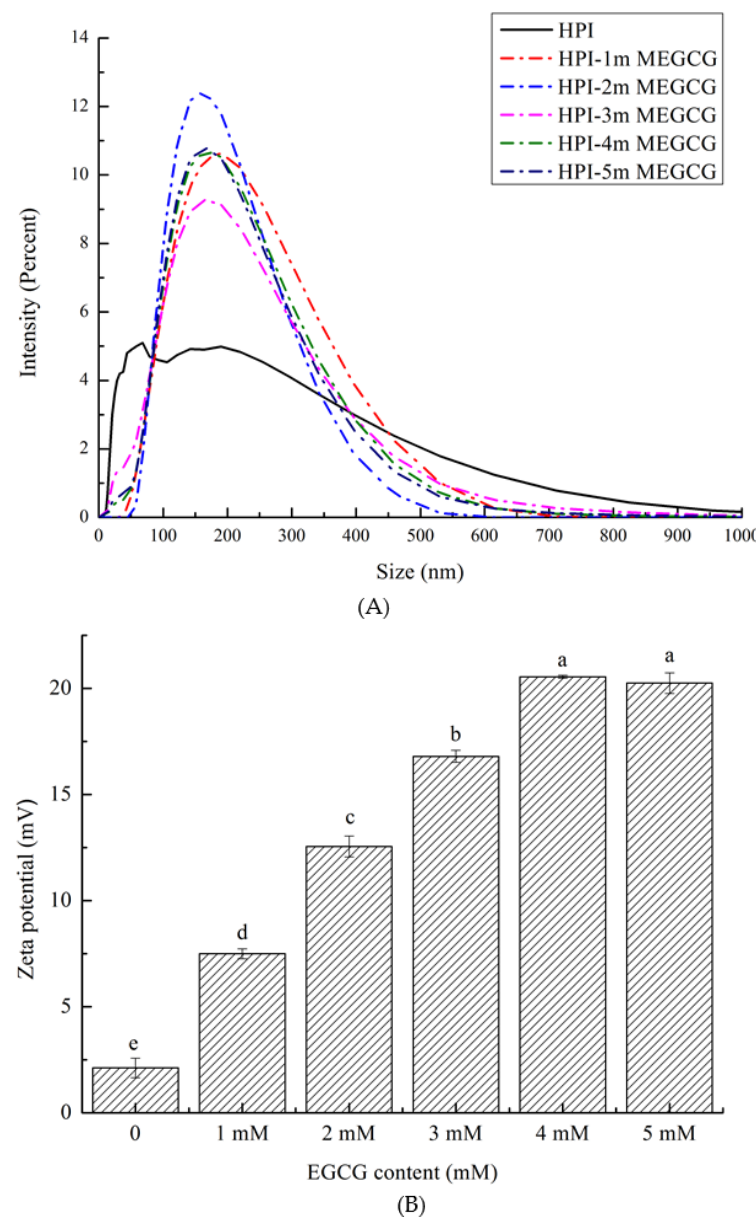
Figure 1. Size distribution ( A ) of HPI and covalent HPI-EGCG complexes at EGCG concentrations of 1, 2, 3, 4, and 5 mM. Zeta potential ( B ) of HPI and covalent HPI-EGCG complexes at EGCG concentrations of 1, 2, 3, 4, and 5 mM.